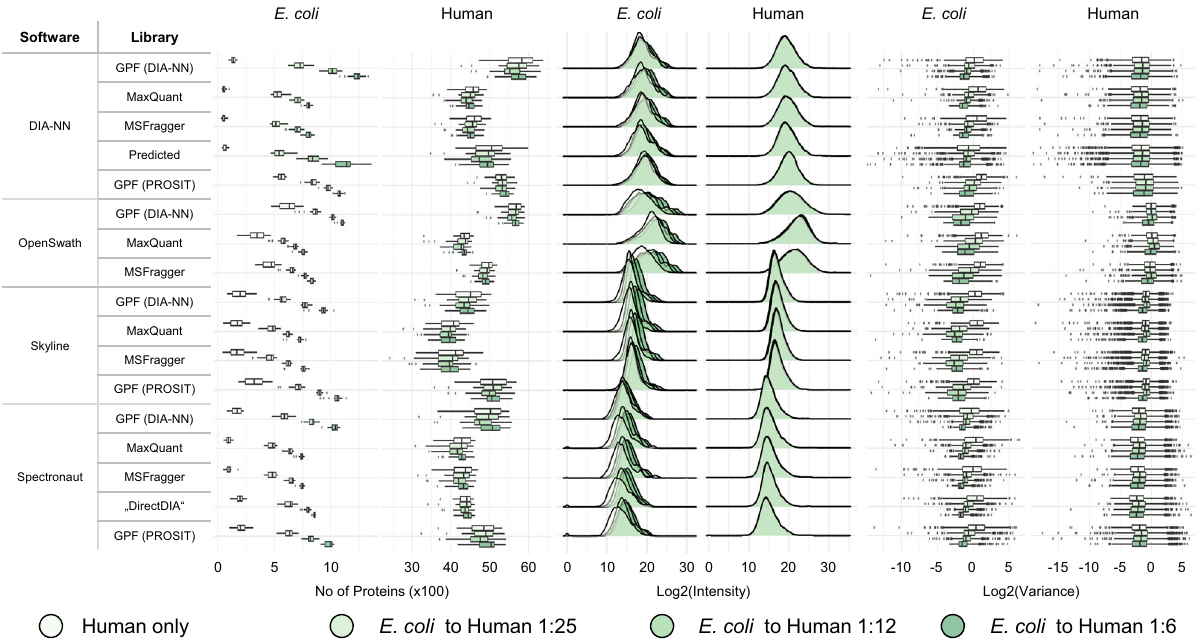
Fig. 2 Choice of spectral library and DIA analysis software in fl uences number of identi fi ed proteins. Protein number, distribution, and variance for each DIA analysis work fl ow separated by species and color-coded by spike-in condition. Left: Number of all identi fi ed and quanti fi ed proteins in all 92 samples. Center: Log2 intensity distributions. Right: Log2 variance. Log2 variance values < − 12 were excluded from this plot. For spike-condition, 1:6 data of n = 22 biologically independent samples have been used and for each of the other spike-in conditions data of n = 23 biologically independent samples have been used. The boxplots show median (center line), interquartile range (IQR, extending from the fi rst to the third quartile) (box), and 1.5 * IQR